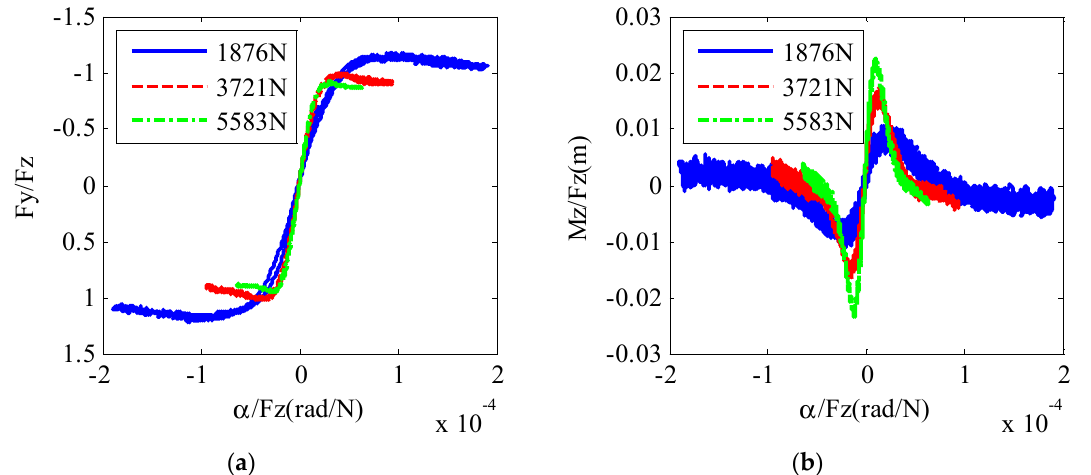
Figure 2. Row tire test data: ( a ) lateral force; ( b ) self-aligning torque.